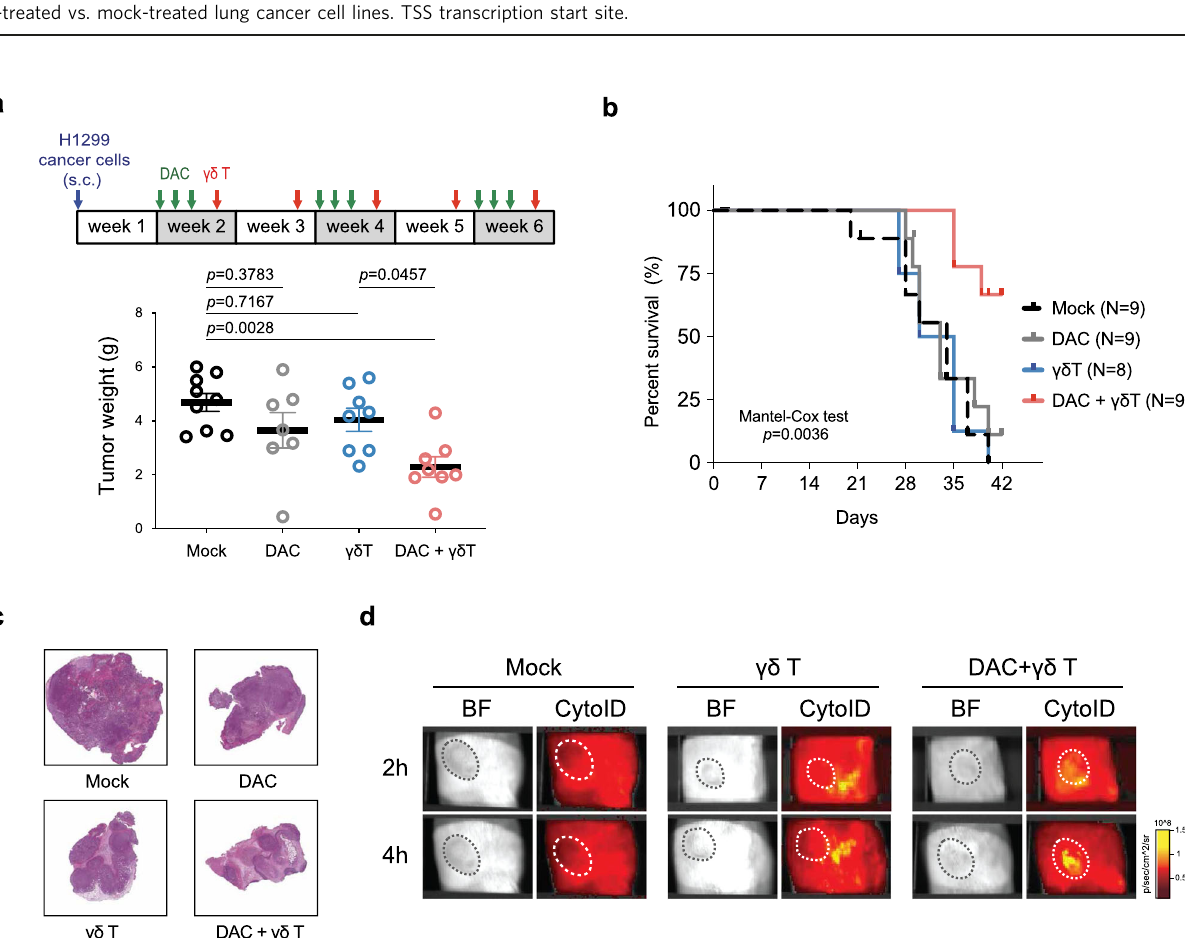
Fig. 6 Decitabine combined with adoptive transfer of γδ T cells prolongs survival of mice with lung cancer xenografts. a In vivo experiment of NOD-scid IL2rg null (NSG) mice bearing H1299 human lung cancer xenografts treated by DAC, adoptive human γδ T transfer, or both. For every cycle of drug treatment, DAC is administered intraperitoneally for three consecutive days, followed by intravenous injection of ex vivo expanded γδ T cells on day 5 and day 12. Mice were killed one day post injection of γδ T cells following the 3rd cycle of the treatment. The tumor was surgically excised, and the weight was measured. The statistic result was determined by one-way ANOVA with Tukey ’ s multiple comparison test. n = 9 mice from two independent experiments (mean ± SEM). s.c. subcutaneously. b Kaplan – Meier survival curve of NSG mice in each treatment group is shown. The p value is calculated by the Mantel- Cox test (one-sided). c Η ematoxylin and eosin (H&E) staining of representative mouse tumors in each treatment group. Images of the whole tumor are generated by a digital slide scanner. d In vivo imaging of γδ T cell traf fi cking in a lung cancer xenograft mouse model. Ex vivo expanded γδ T cells were prestained with CYTO-ID Red long-term cell tracer dye. The NSG mice bearing H1299 lung cancer xenografts were treated with DAC (0.2 mg/Kg BW) or normal saline intraperitoneally for three consecutive days (day 1 – 3), followed by tail vein injection of the prestained γδ T cells on day 5 and day 12. The images were taken at 2 and 4 h after γδ T injection using IVIS Spectrum (Ex570, Em640) on day 12. Experiments were done in replicates. Representative images are shown here. BF bright fi eld, White circle tumor